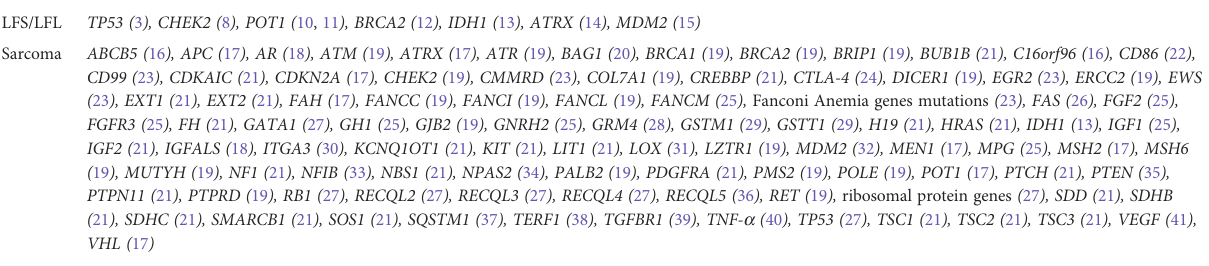
TABLE 2 List of candidate genes associated with LFS/LFL and sarcoma. Disease